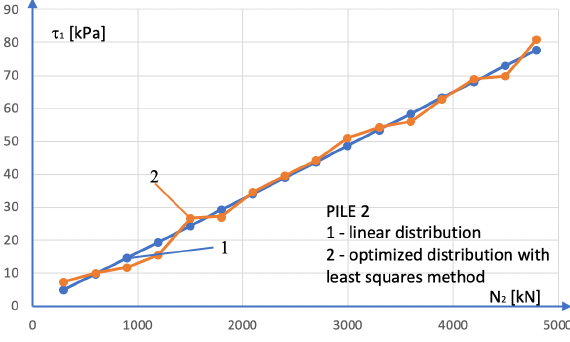
Figure 9b: Pile 2 values comparison; linear distribution for B